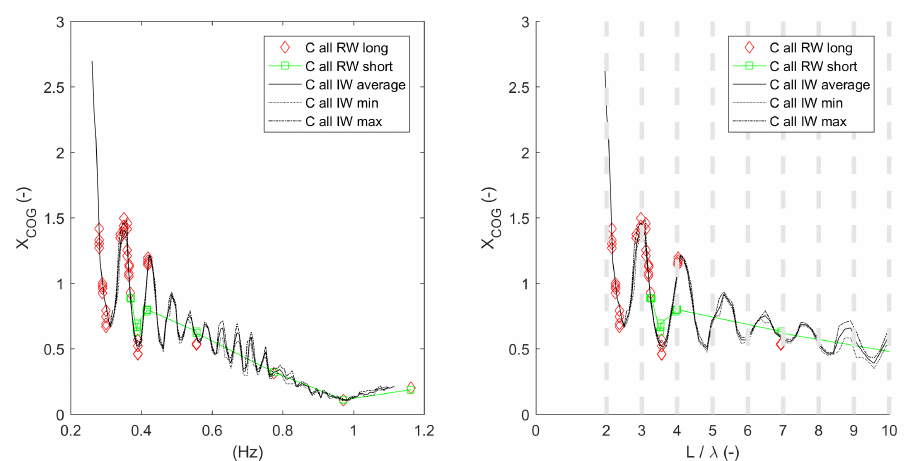
Figure 20. Surge RAOs from regular and irregular waves in basin C (as function of frequency ( left ) and ratio of basin’s length by wave length ( right